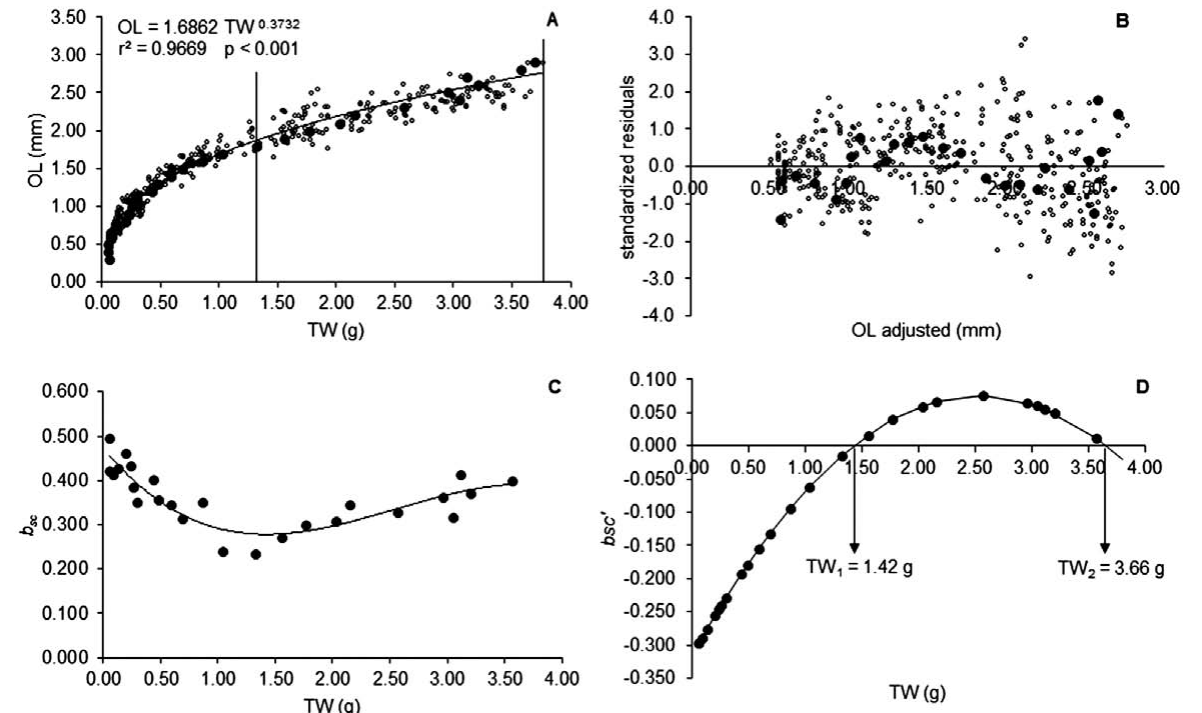
Fig. 5. – A, power regression between total weight (TW) and otolith length (OL) of Anchoa tricolor of the Paranaguá Estuarine Complex (Paraná State, Brazil) (open circle = individual measurements; filled circle = average values for 0.1 mm OL class. B, standardized residuals adjusted from power regression. C, exponential coefficient ( b ) for each total weight (line = polynomial function). D, first derivativee of sc polynomial function showing the stanza changing points of total weight (TW and TW ). 1 2 Table 1. – Huxley model (power regressions, y= a x b ) between total length (TL) and shape indices (see the text for details) of Anchoa